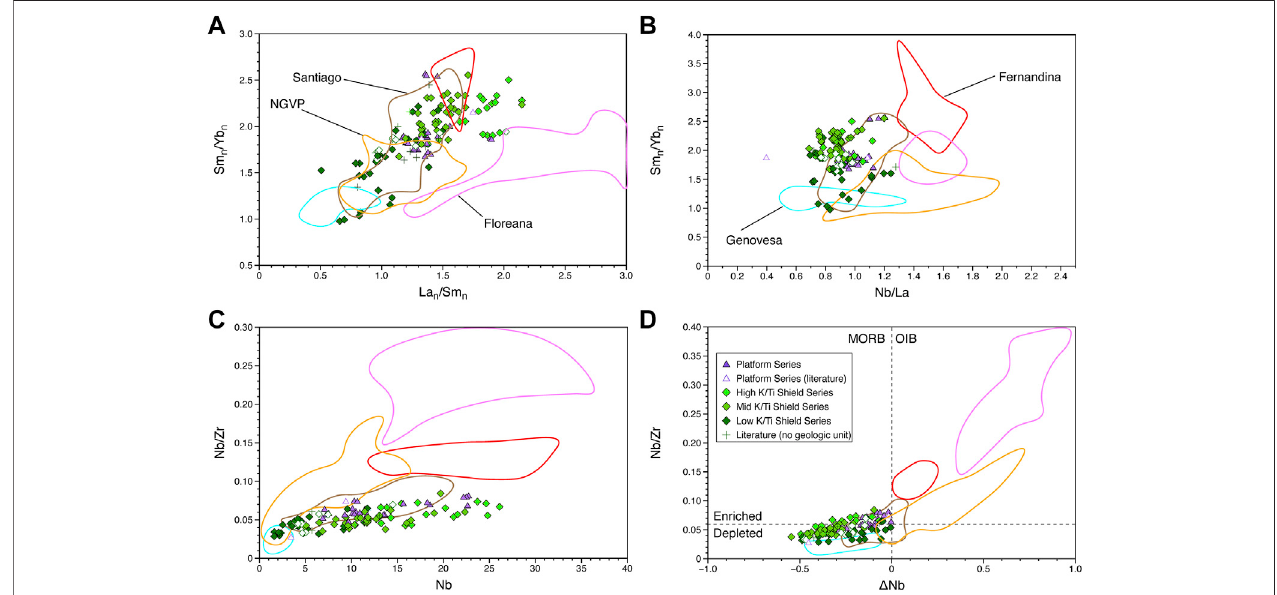
FIGURE 7 | Santa Cruz incompatible trace element ratio variations relative to selected Galápagos Islands. Fields are literature data. Red: Fernandina, blue: Genovesa, brown: Santiago, pink: Floreana, yellow: Northern Galápagos Volcanic Province (Bow and Geist, 1992; White et al., 1993; Harpp et al., 2002; Harpp et al., 2003; Saal et al., 2007; Gibson and Geist, 2010; Gibson et al., 2012; Harpp et al., 2014a; Harpp et al., 2014c). (A) Chondrite-normalized La n /Sm n and Sm n /Yb n ratios (McDonoughandSun,1995). (B) Nb/Laversuschondrite-normalizedSm n /Yb n ratios. (C) NbversusNb/Zr. (D) Δ NbversusNb/Zrdiscriminationdiagramtoidentify origin of depleted signatures. Δ Nb (Fitton et al., 1997) = 1.74 + log(Nb/Y) − 1.92 log(Zr/Y). Δ Nb > 0 is attributed to lower mantle origin (OIB fi eld); Δ Nb < 0 indicates depletedmantleorigin(MORB fi eld).LavaswithNb/Zr > 0.06areconsideredenriched,andthosewithNb/Zr < 0.06aredepletedaccordingtoFittonetal.(2003).Several Floreana literature data extend to Nb/Zr = 0.655 and Δ Nb = 0.939, but are not shown. Samples indicated by a cross are literature data from Santa Cruz (White et al., 1993; Kurz and Geist, 1999; Saal et al., 2007); they have not been attributed to either the Platform or Shield Series owing to a lack of GPS coordinates for their origin